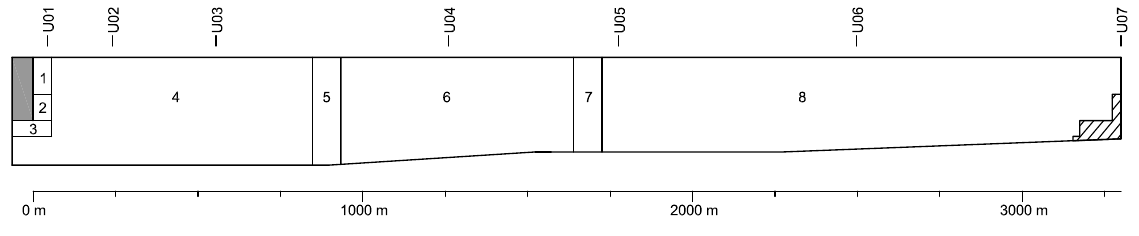
Figure 11. Zones for the calibration of the hydraulic conductivity k and leakage parameters c . l